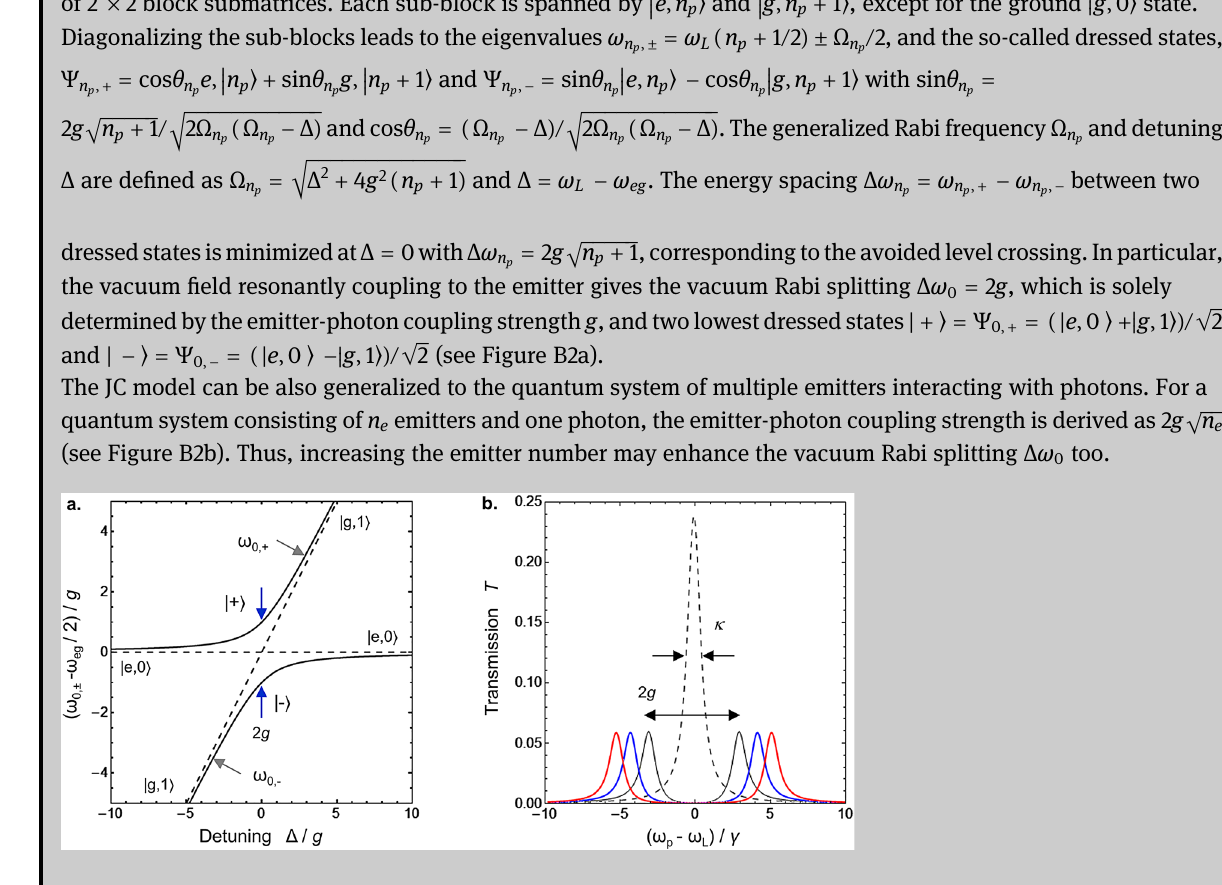
Figure B2: Cavity QED spectrum. (a)Energyspectrum ω 0 , ± ofthequantumsystemcomposedofoneemitterandonephotonasafunctionofthedetuning Δ = ω L − ω eg between cavity ω L andemitter-transition ω eg frequencies.Thepresenceofanti-crossingbetweentwoenergy-levelbranchesat Δ = 0provestheformation of polaritons, | + 〉 = (| e , 0 〉 +